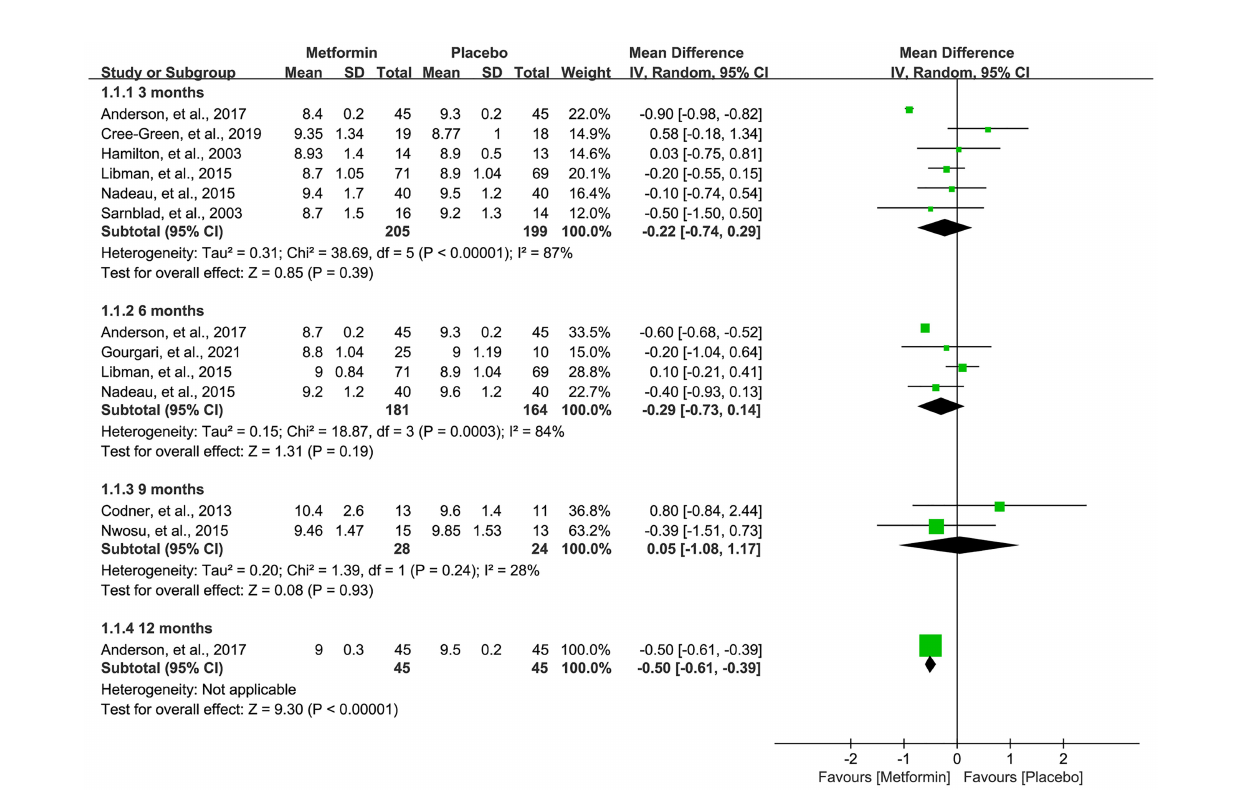
FIGURE 3 | Forest plot of the comparative ef fi cacy between metformin and placebo in terms of HbA1c at different follow-up